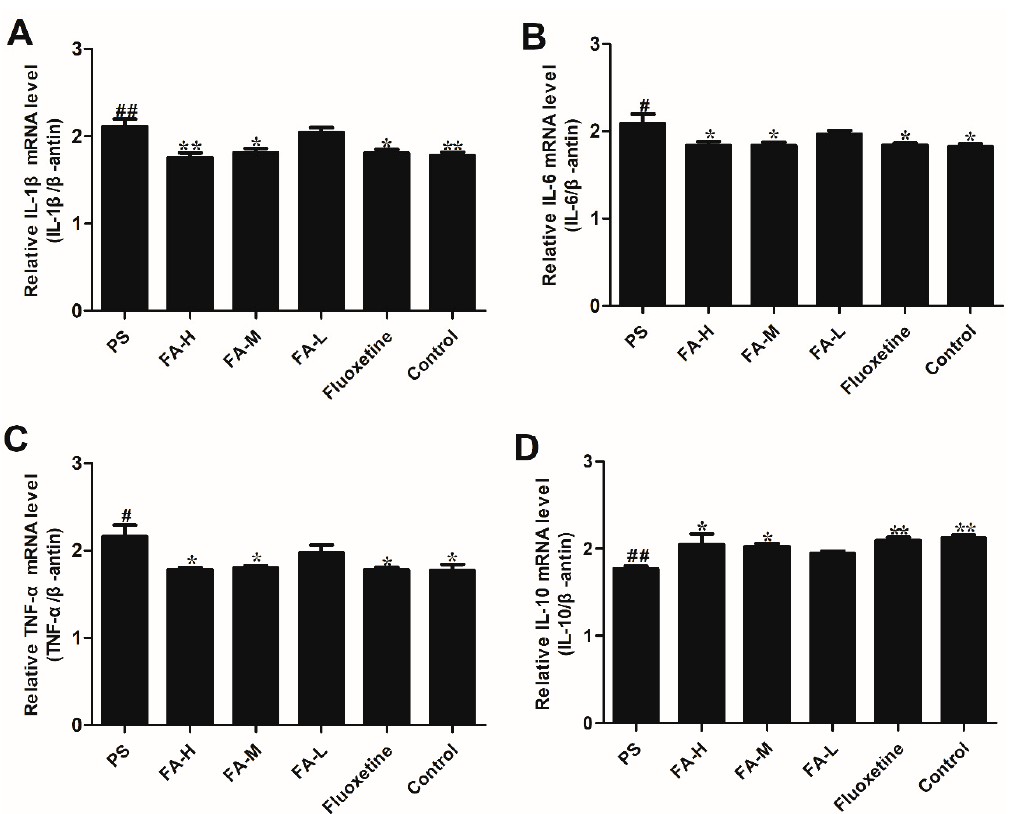
Figure 8. Effects of ferulic acid (FA) on the cytokine mRNA expression in the hippocampus of offspring rats exposed to prenatal stress. Results of ( A ) IL-1 β mRNA in hippocampus of the offspring. ( B ) IL-6 mRNA in in the hippocampus. ( C ) TNF- α mRNA in the hippocampus. ( D ) IL-10 mRNA in the hippocampus were quantified by real-time PCR. Values represent means ± SEM ( n = 3). * p < 0.05 and ** p < 0.01 compared with PS group, # p < 0.05 and ## p < 0.01 compared with Control group. FA-L: FA at low 12.5 mg/kg/day, FA-M: FA at medium 25 mg/kg/day, FA-H: FA at high 50 mg/kg/day.